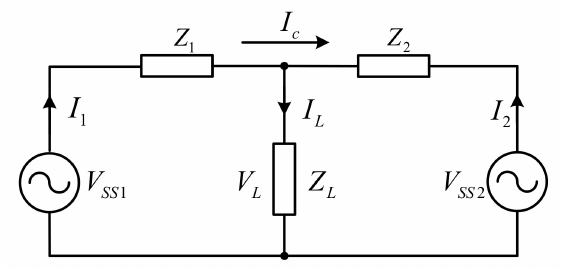
Figure 3. Equivalent circuit of two